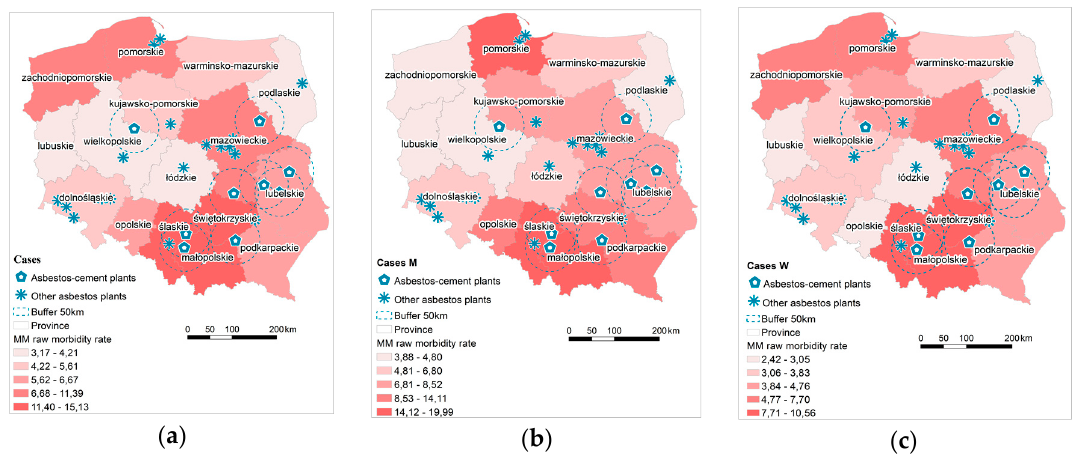
Figure 4. Malignant Mesothelioma (MM) raw morbidity rate ( a ) cases all; ( b ) cases M (men); ( c ) cases W (women). W (women).